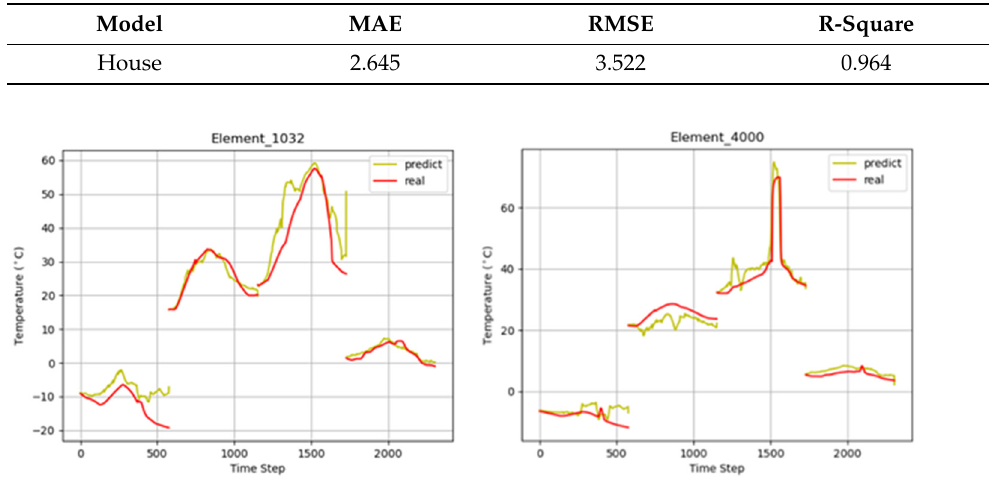
Table 4. MTPHNet’s generalization performance for temperature field prediction of complex objects.